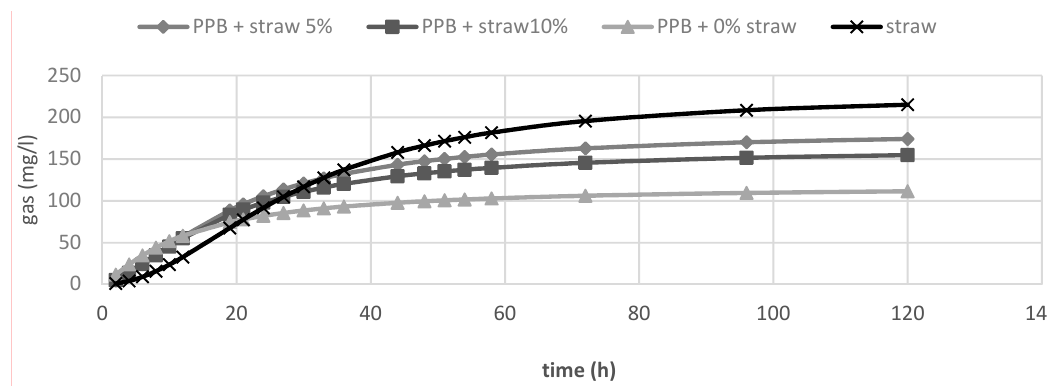
Figure 1. In vitro gas production over time of prickly pear by-products (PPB) silages and wheat straw.